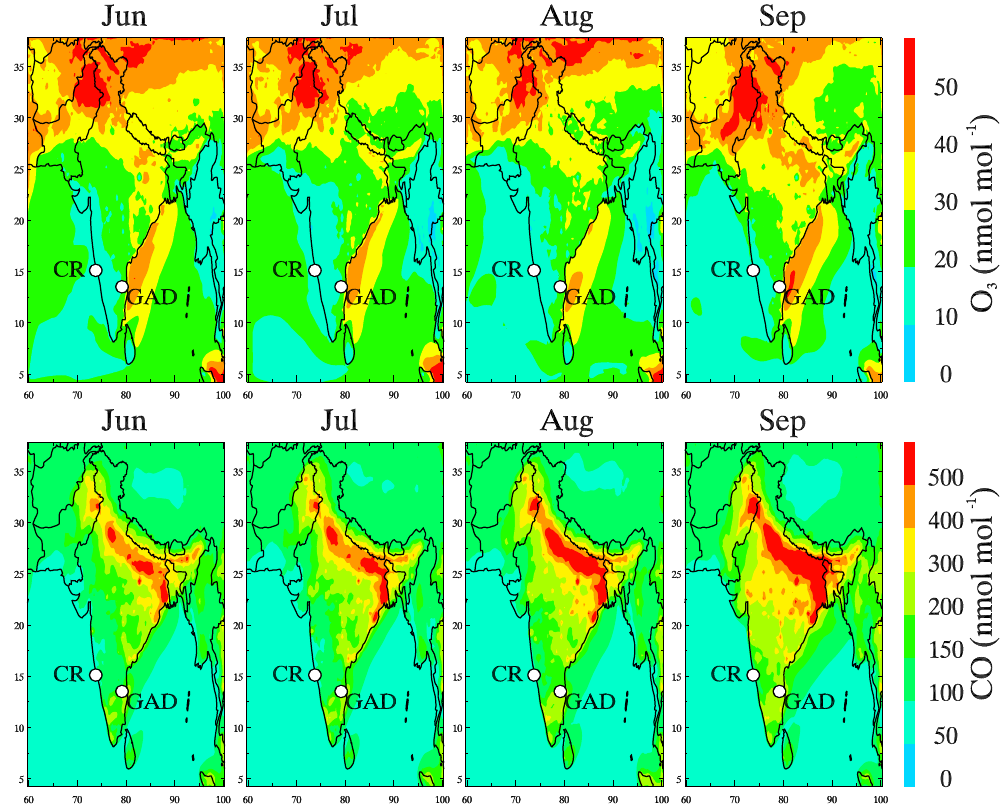
Figure 7. Spatial distribution of monthly average surface ozone and CO (nmolmol − 1 ) from WRF-Chem simulations (Std) during June, July, August and September 2008. The locations of two surface sites, Cape Rama (CR) and Gadanki (GAD), are also